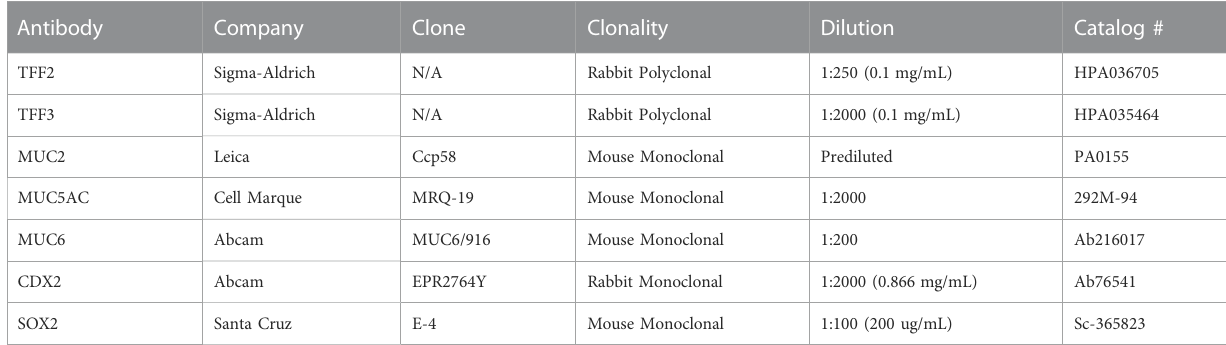
TABLE 1 Summary of primary antibodies.